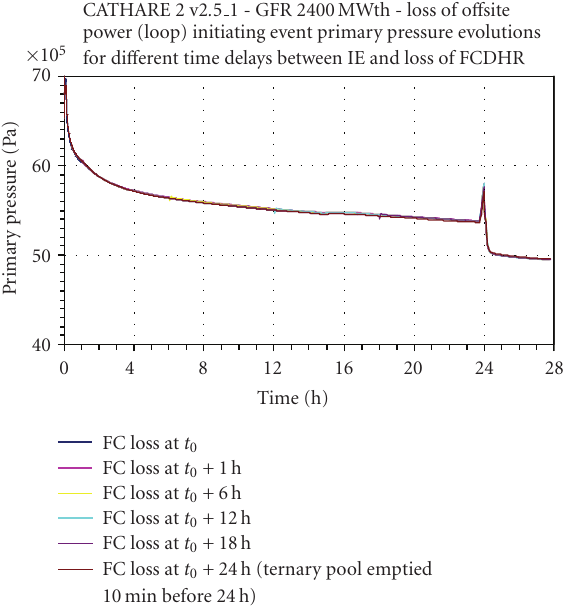
Figure 5: Influence of the time limit before NC actuation on the primary pressure evolutions (1 DHR loop available).